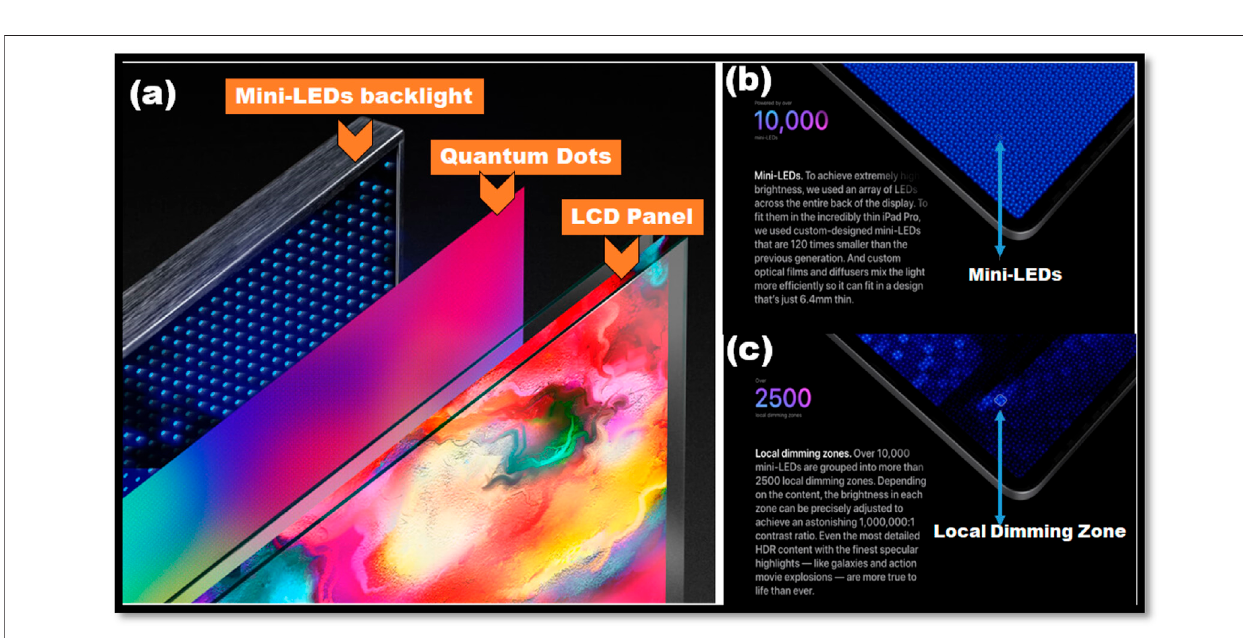
FIGURE 2 | (A) Schematic of QD-mini-LED by using mini-LED and QD fi lm from the TCL US of fi cial website. (B) Mini-LED backplane and (C) local dimming technology used in iPad Pro 12.9 (2021) from the Apple of fi cial